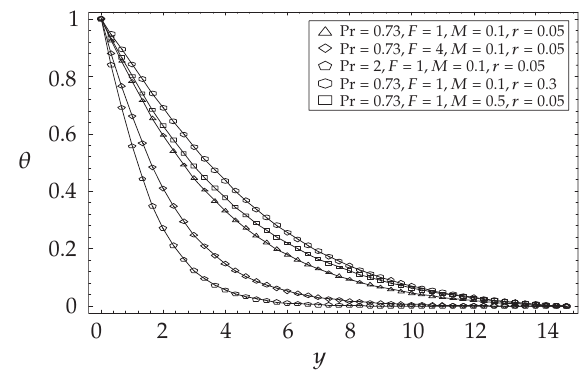
Figure 3.3 . Variation of the dimensionless temperature θ with Pr ,M,r , and F